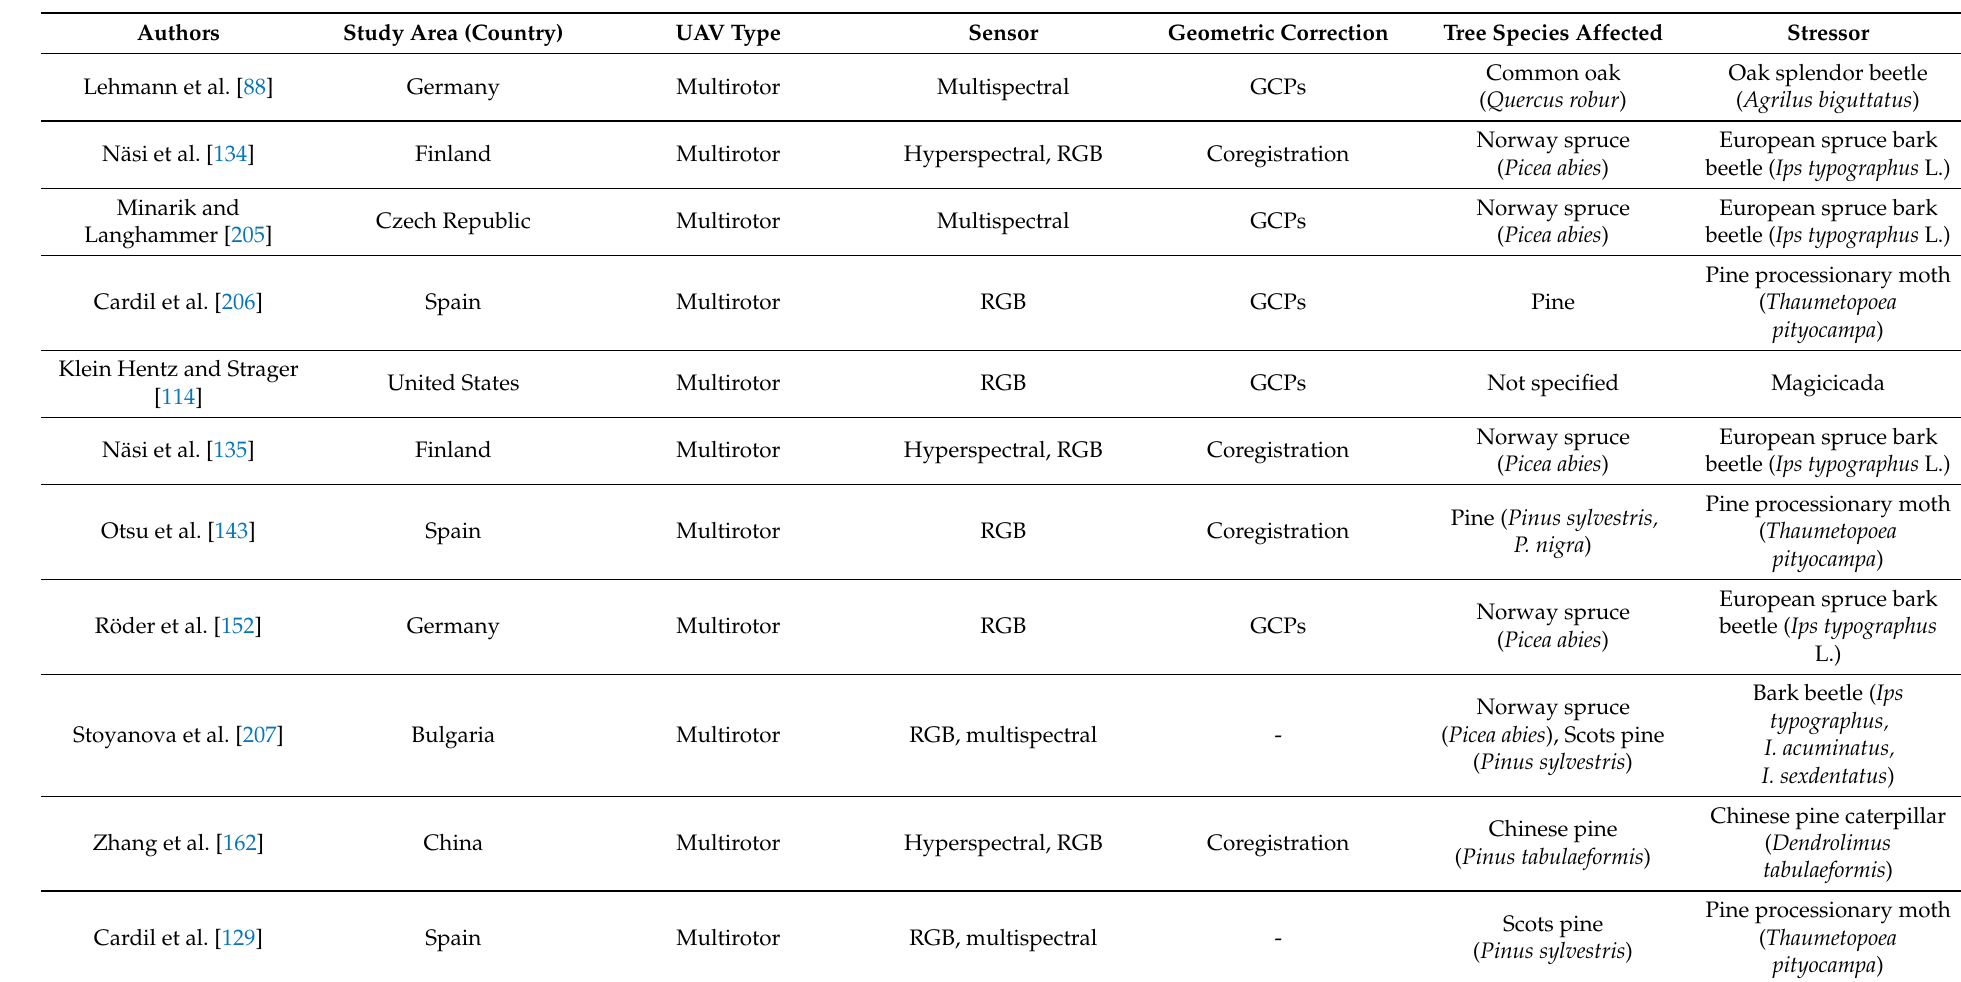
Table A1. Pests: reviewed articles regarding insects as the cause of tree